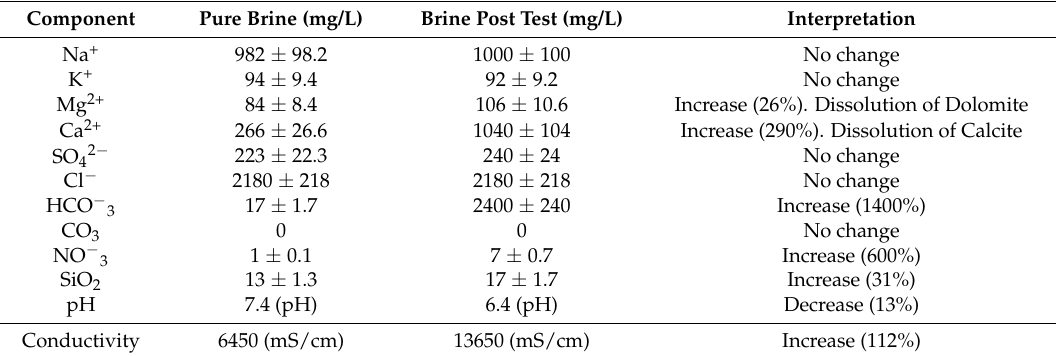
Table 2. Chemical analysis of pure brine and brine taken from the reaction chambers. Uncertainty (10%) given by IGME Laboratory.